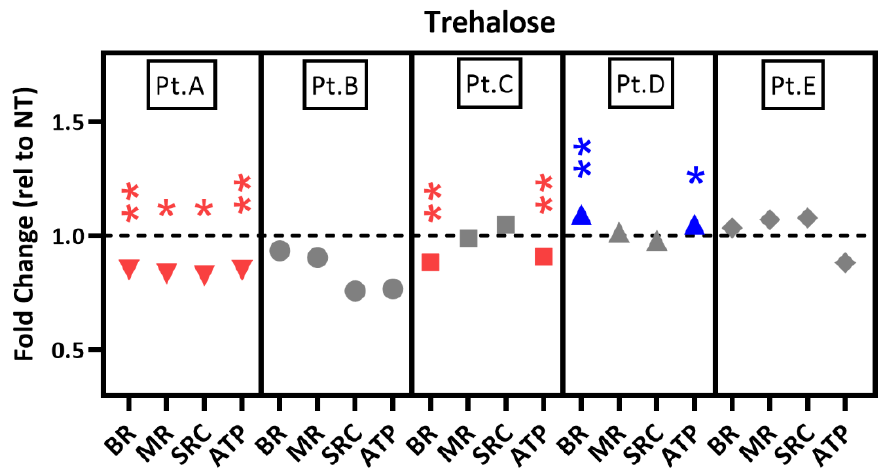
Figure 6. Testing an autophagy inducer using AMD patient-specific iPSC-RPE. iPSC-RPE cells from patients with AMD ( n = 4) were treated with trehalose for 48 h. Following treatment, parameters of mt function were calculated from OCR measured using an XFe96 Extracellular Flux Analyzer. OCR data were normalized to cell count per well. Graphs show the fold change relative to each donor’s